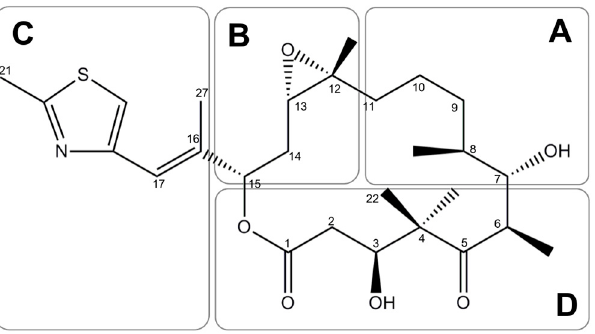
Figure 3. Subdivision of the EpoB structure into four regions ( A – D ) based on structure activity re- lationship [9,25]